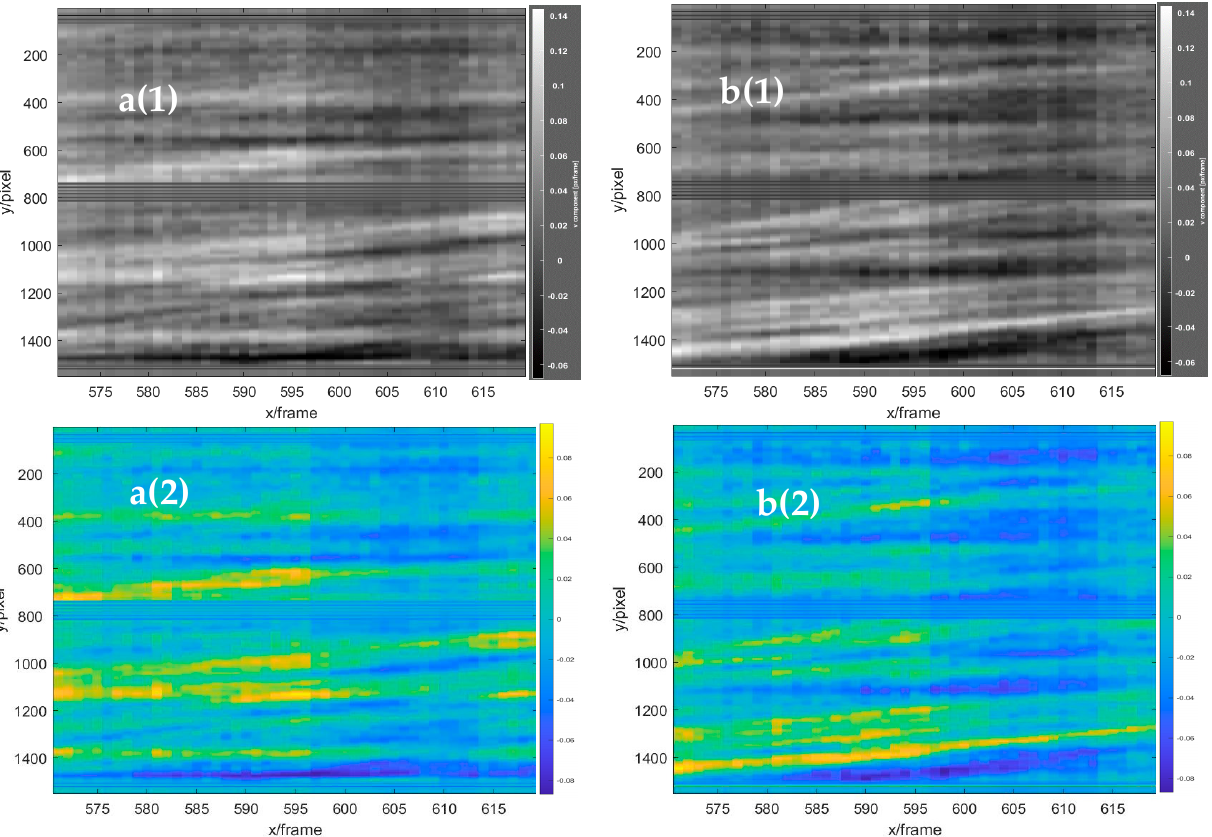
Figure 20. The stacked baseline analysis graphs in the vertical direction of 50 frames. a ( 1 ) Baseline a (gray scale), and a ( 2 ) baseline a (RGB color). b ( 1 ) Baseline b (gray scale), and b ( 2 ) baseline b (RGB color).